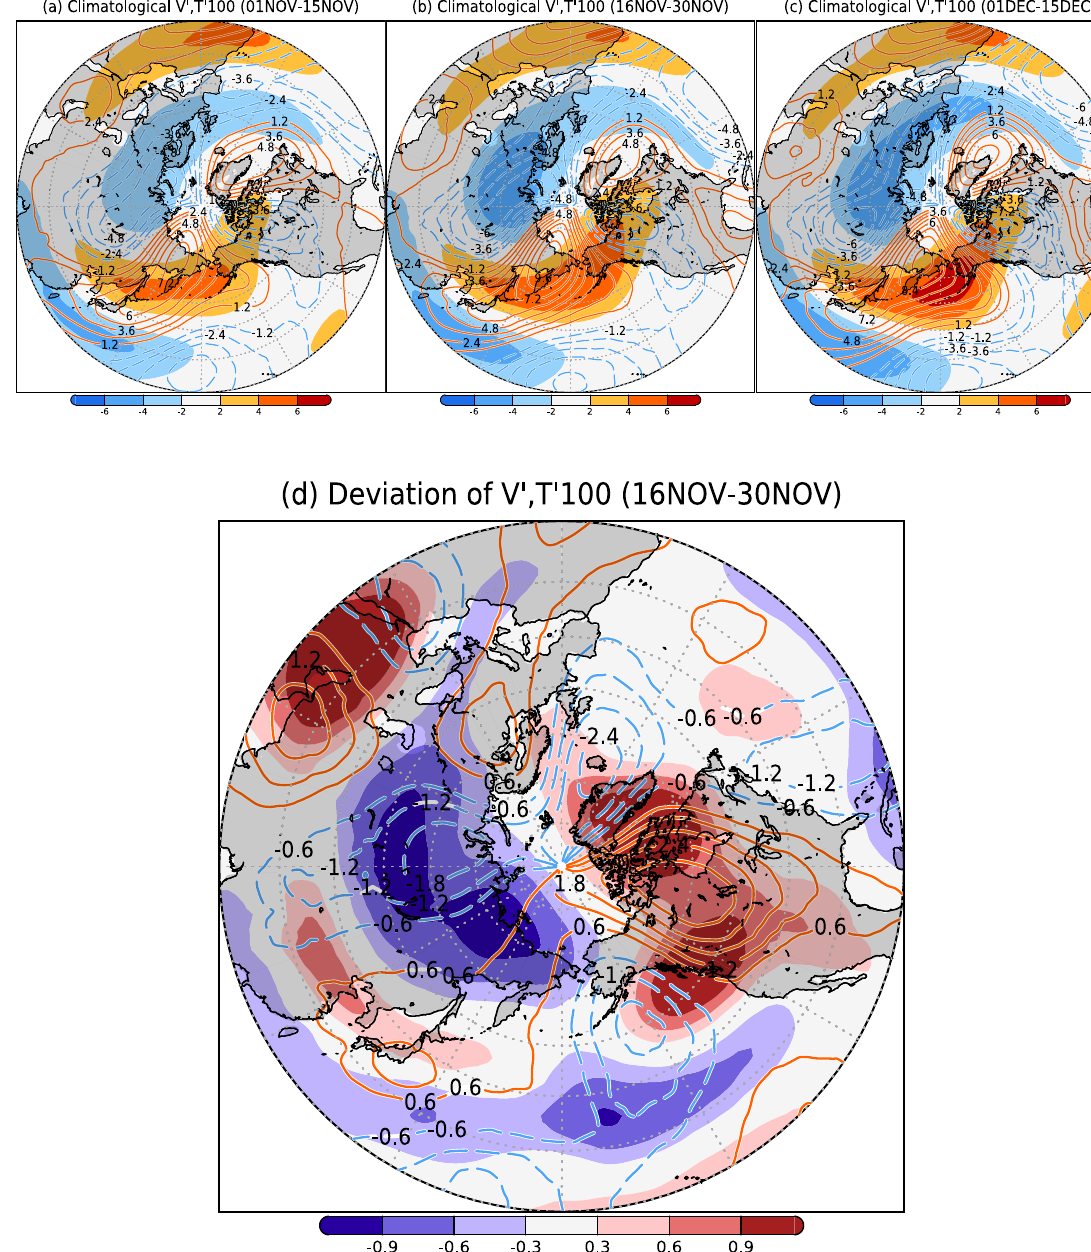
Figure D4. Zonal anomalies of climatological meridional wind (ms − 1 , contours) and air temperature ( ◦ C, color shading) at 100hPa during (a) early November, (b ) late November, and (c) early December. (d) Late November deviations calculated by Eq. (4) (see Sect.